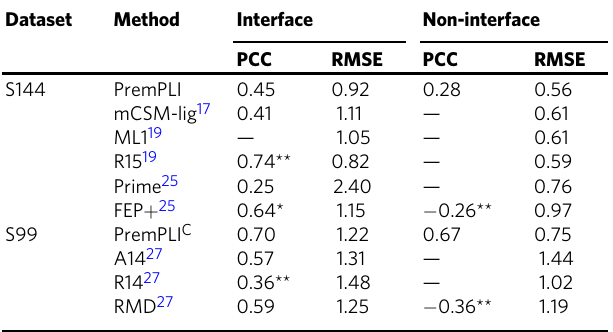
Only correlation coef fi cients statistically signi fi cantly different from zero are shown ( p -value < 0.05, t -test). * and ** indicate statistically signi fi cant difference between PremPLI and other methods in terms of PCC (Hitter et al. 51 test) with p -value < 0.05 and p -value < 0.01,